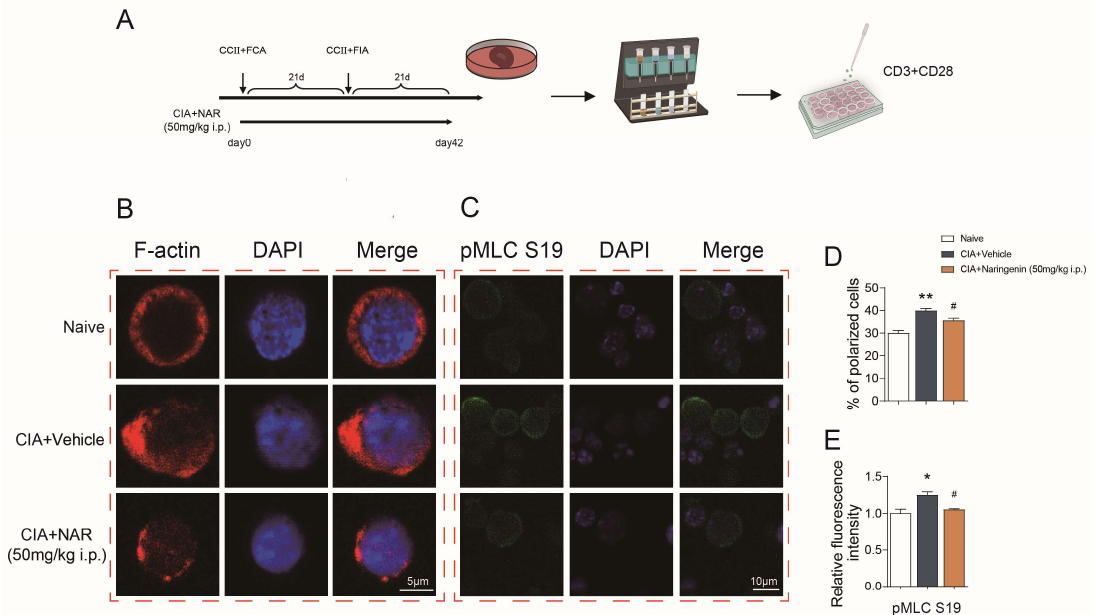
Figure 3. NAR ameliorated CD4 + T lymphocyte polarization in the spleen of CIA model rats. ( A ) Flowchart of using magnetic beans to sort CD4 + T lymphocytes. ( B ) F-actin shown by immunofluorescence. ( C ) Immunofluorescence showing the expression of pMLC in the CD4 + T lymphocyte in different groups. ( D ) The bar chart shows the percentage of polarized cells. ( E ) The bar chart shows the relative fluorescence intensity of pMLC S19. * p < 0.05, ** p < 0.01 vs. naive group, # p < 0.05 vs. CIA model group, by repeated-measures one-way ANOVA followed by post hoc Dunnett’s multiple comparisons test. All scale bars are 5 µ m ( B ) or 10 µ m ( C ). The data are presented as means ± SEM (3 sections and 3–5 different fields of each section were randomly selected for semi-quantitative evaluation).